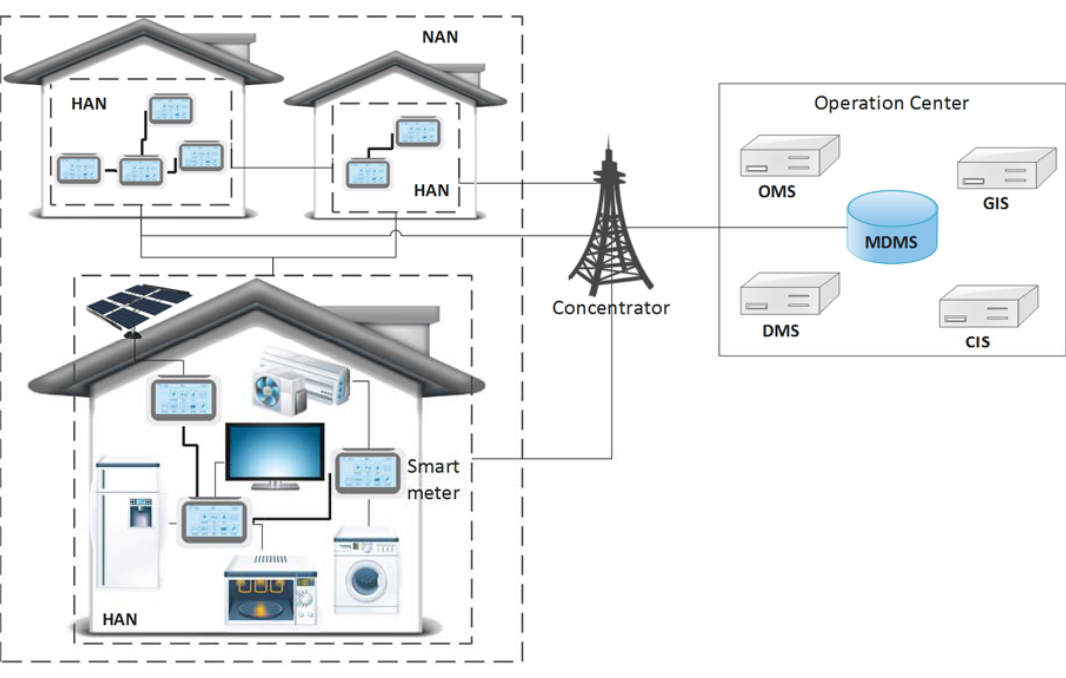
Figure 4. Basic elements of an AMI.